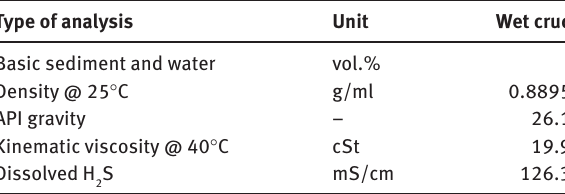
Table 2: Properties of the wet crude sample from the west of